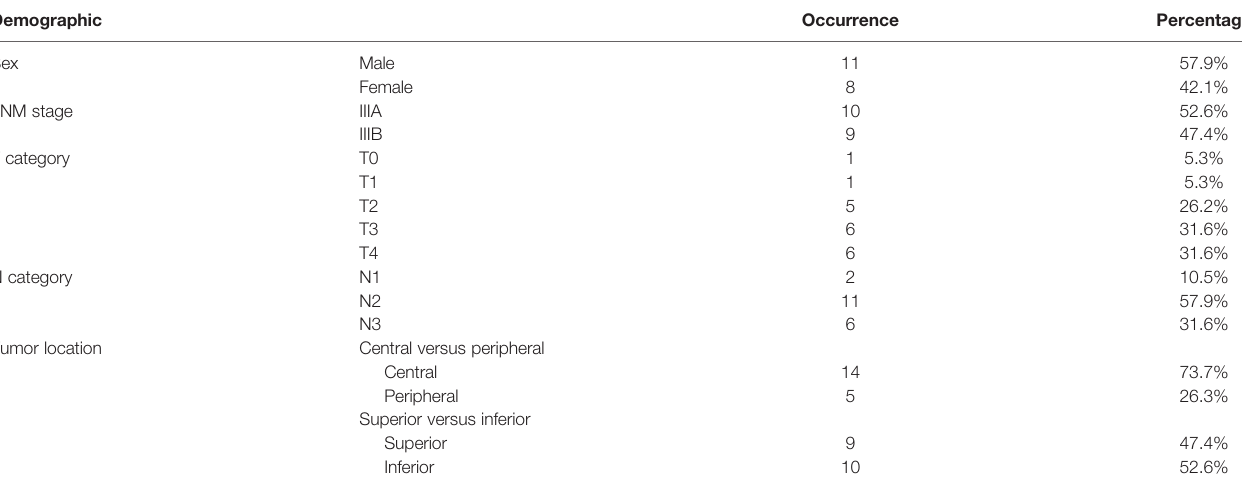
TABLE 1 | Patient characteristics (n =